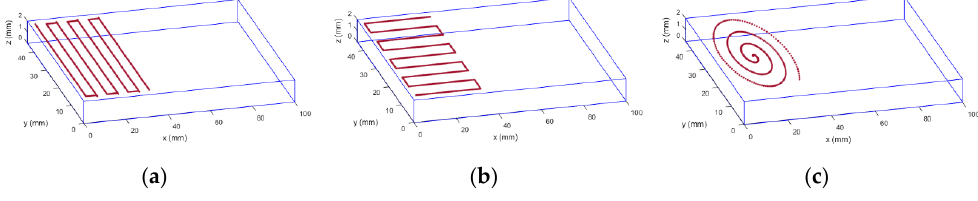
Figure 4. Simulated joining trajectories: ( a ) parallel to y ; ( b ) parallel to x ; ( c ) spiral